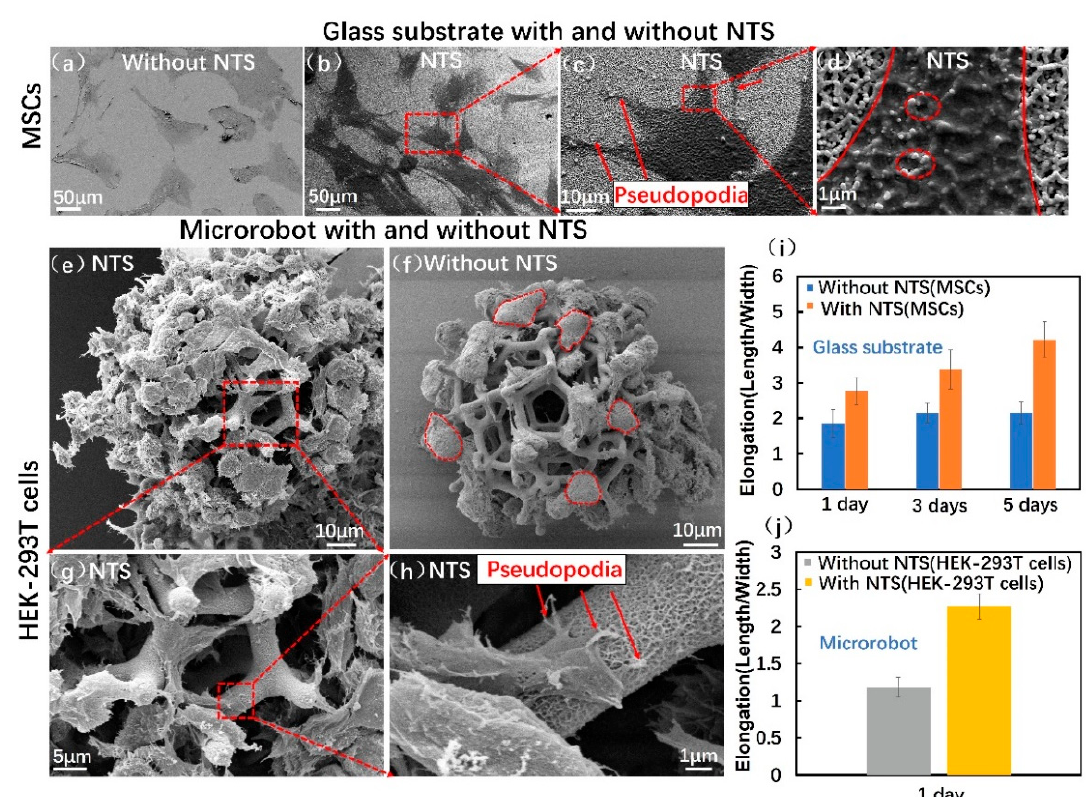
Figure 3. Cell morphology on NTS: ( a ) SEM image of MSCs on glass substrate without NTS after 1 day of incubation; ( b ) SEM image of MSCs on NTS sample after1 day of incubation; ( c ) SEM image of single MSC with protrusive pseudopodia on NTS sample; ( d ) High-magnification SEM image of interplay between the MSC and the NTS; ( e ) SEM image of HEK-293T cells on microrobot with NTS after 1 day of incubation; ( f ) SEM image of HEK-293T cells on microrobot without NTS; ( g ) High-magnification SEM image of HEK-293T cells on microrobot with NTS; ( h ) High-magnification SEM image of single HEK-293T cell with protrusive pseudopodia on microrobot with NTS; ( i ) Histogram representing the average elongation of MSCs on glass substrate with and without NTS cultured for 1, 3, and 5 days (n = 100); ( j ) Histogram representing the average elongation of HEK-293T cells on microrobot with and without NTS cultured for 1 day (n = 100). Error bars indicate